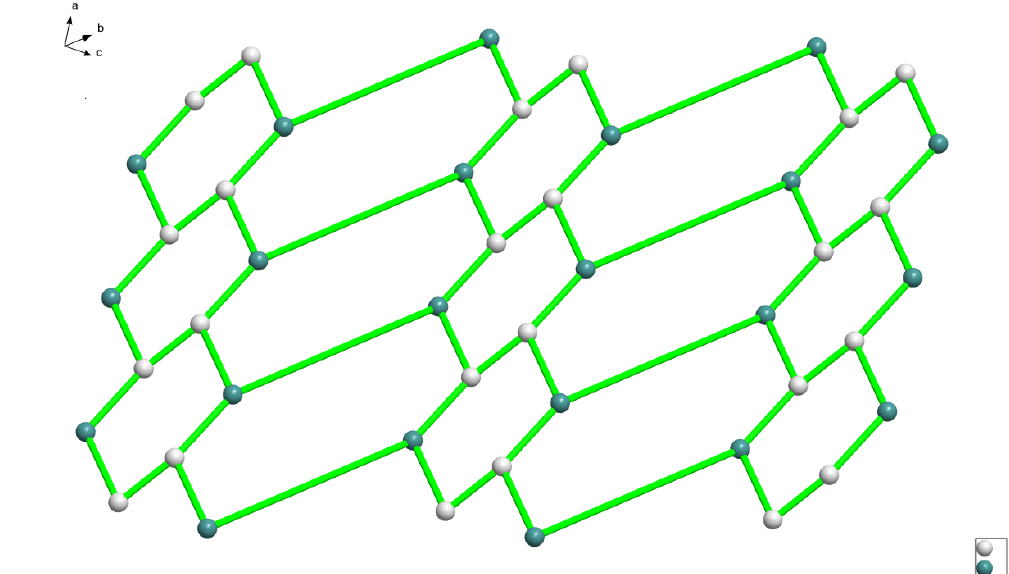
Figure 9. A perspective view of the topological structure of complex 2 .